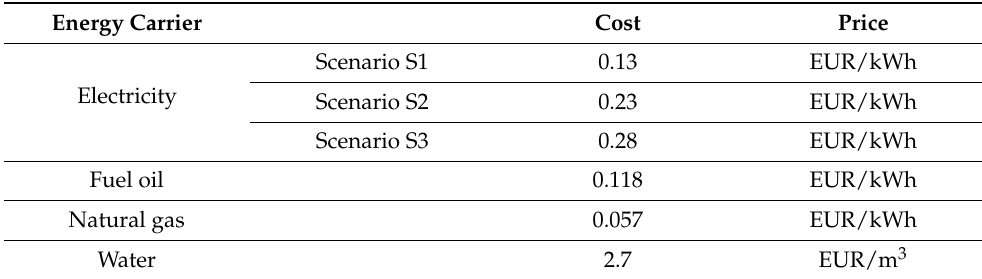
Table 4. Energy prices.